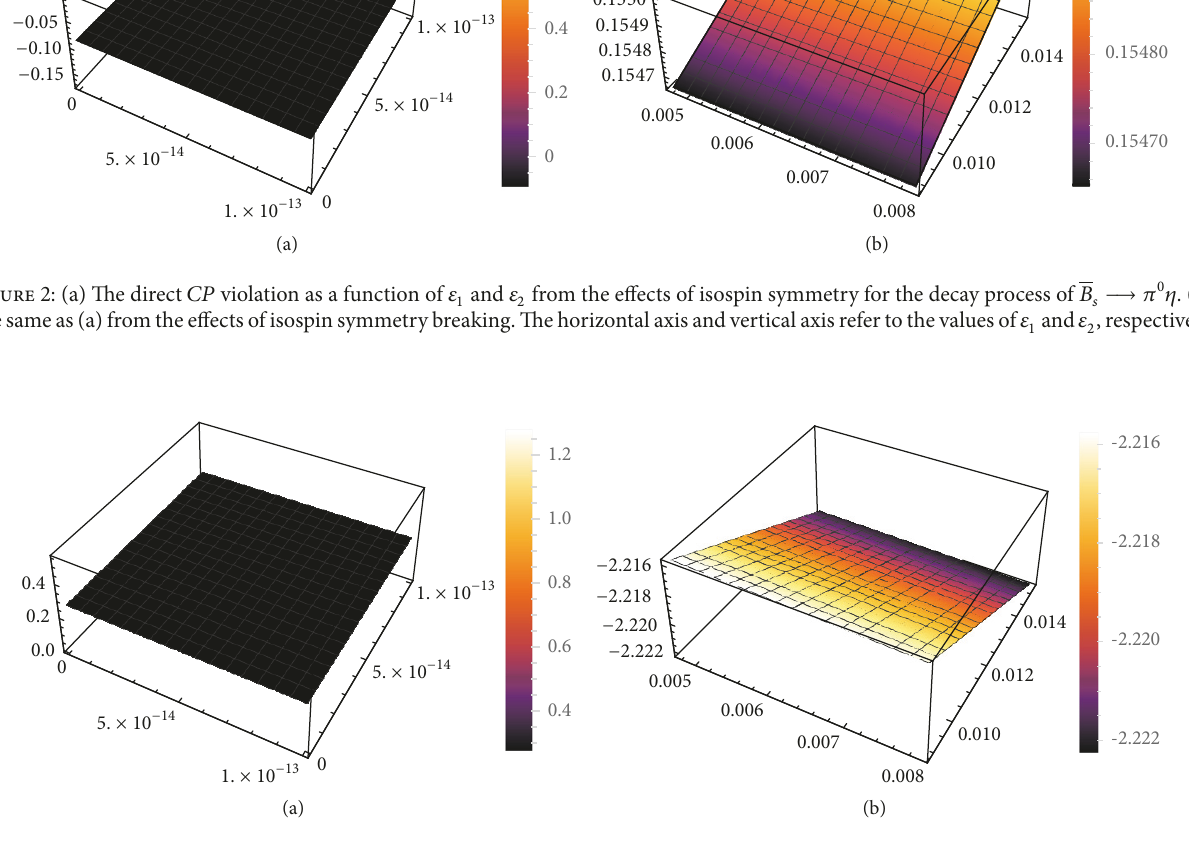
Figure 3: (a) The value of sin 𝛿 as a function of 𝜀 1 and 𝜀 2 from the effects of the isospin symmetry for the decay process of 𝐵 𝑠 󳨀→ 𝜋 0 𝜂 . (b) The same as (a) from the effects of isospin symmetry breaking. The horizontal axis and vertical axis refer to the values of 𝜀 1 and 𝜀 2 , respectively.